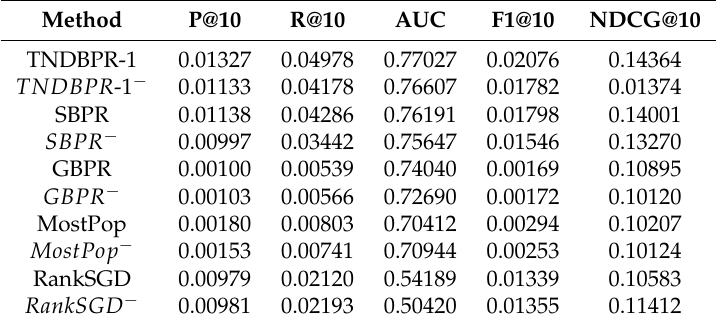
Table 3. Comparison results on Epinions dataset without dropping low ratings.